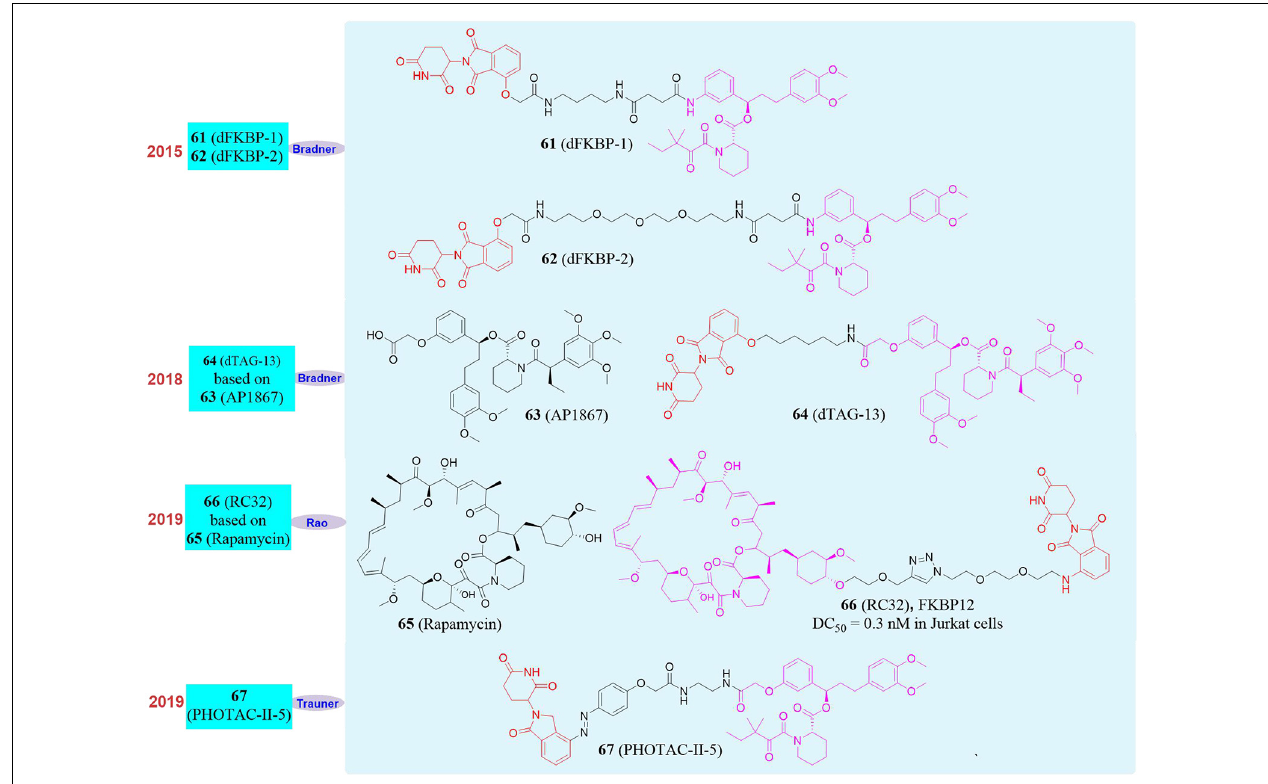
FIGURE 11 | Structures of FKBP12 inhibitors and